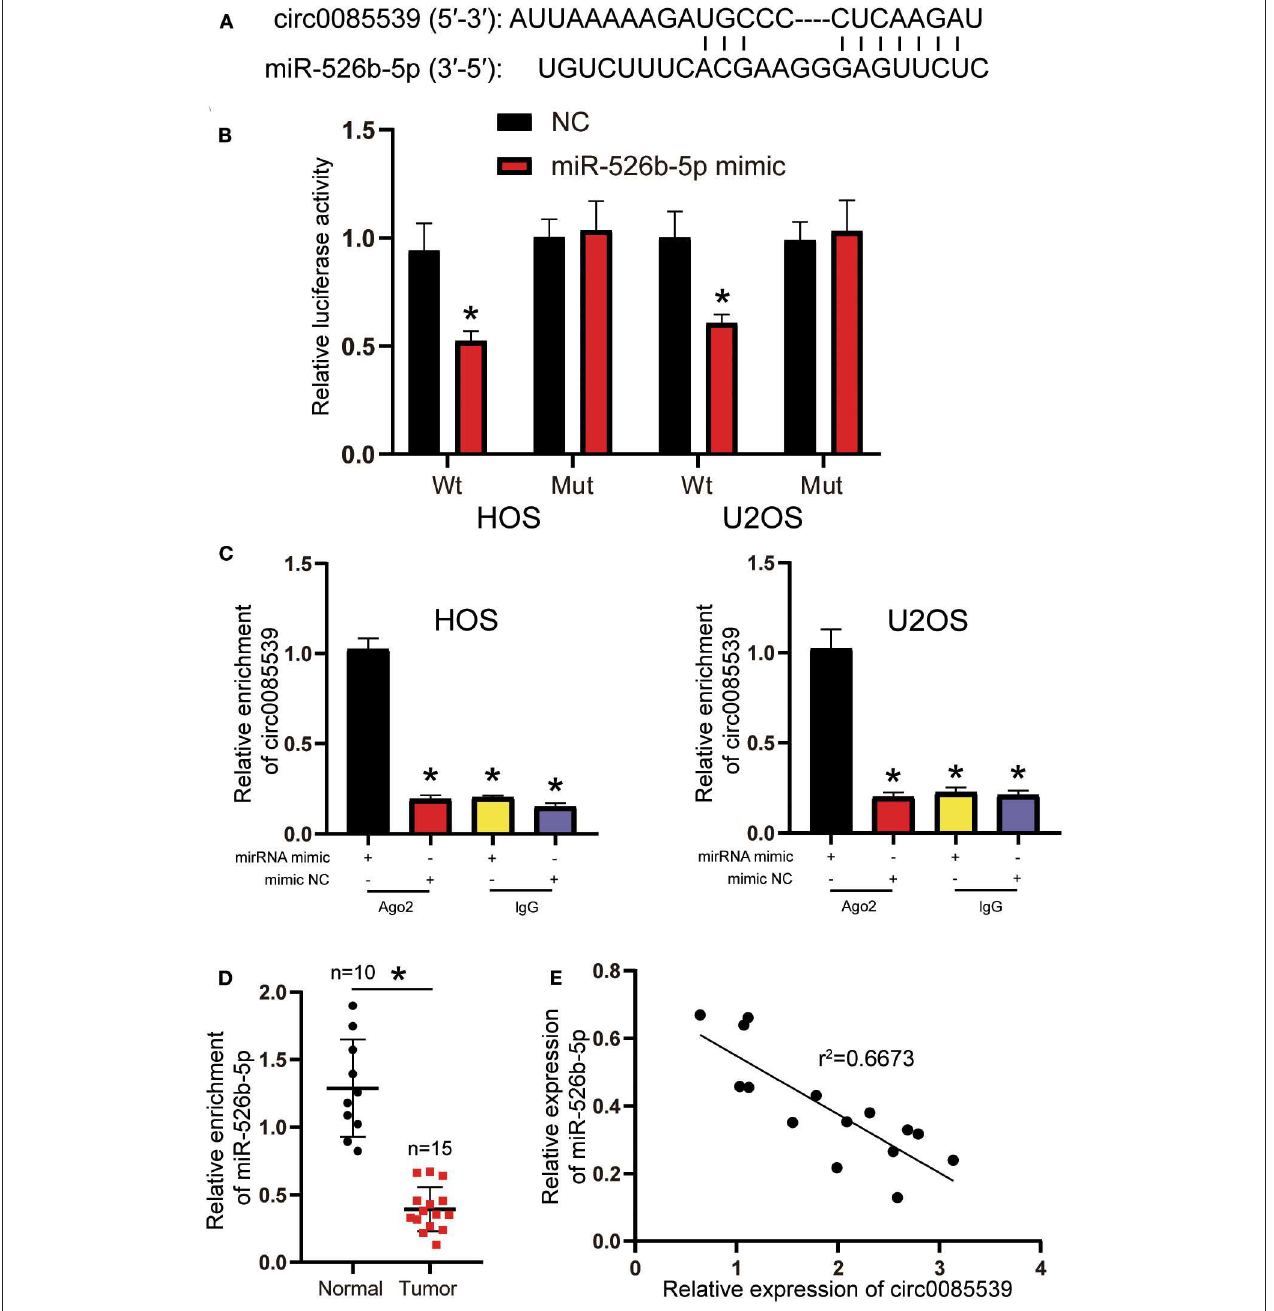
FIGURE 3 | Circ0085539 acted as a sponge for miR-526b-5p. (A) Potential binding scheme between miR-526b-5p and circ0085539. (B) Luciferase reporter gene assay in osteosarcoma (OS) cells cotransfected with miR-526b-5p mimic and circ0085539-Wt or circ0085539-Mut reporter plasmids. (C) RNA immunoprecipitation (RIP) results showed that circ0085539 was abundantly pulled down in miR-526b-5p mimic group in the presence of anti-Ago2 antibodies in HOS and U2OS cells. Immunoglobulin G (IgG) was the negative control. (* p < 0.05 compared with miR-526b-5p mimic + Ago2 group). (D) The expression of miR-526b-5p in 15 osteosarcoma and 10 adjacent tissues was determined by quantitative reverse transcription PCR (qRT-PCR) analysis. Normal: adjacent tissues. * p < 0.05 compared with adjacent tissue. (E) Correlation analysis showed that miR-526b-5p expression was inversely associated with circ0085539 expression in OS tissues. of osteosarcoma, circHIPK3 was obviously downregulated in OS. Circ001569 functioned as an onco-circRNA in osteosarcoma osteosarcoma, and its enhanced upregulation led to the inhibition and promoted cell proliferation through activating the Wnt/ β - of proliferation, migration, and invasion of OS cells (30). These catenin signaling pathway (29). Inversely, as a suppressor